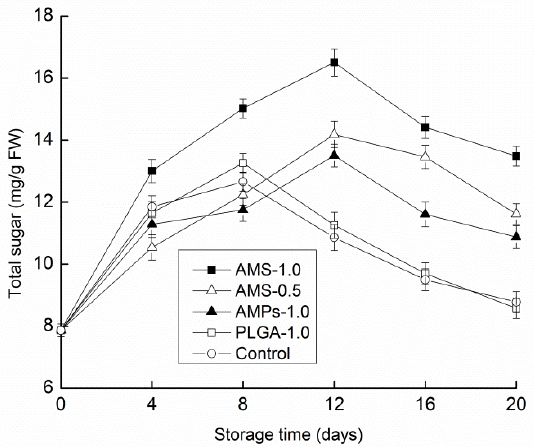
Figure 5. Effect of different antimicrobial coatings on total sugar changes of Tricholoma matsutake stored at 4 ± 1 °C for 20 days. Each data point is the mean of three replicate samples.